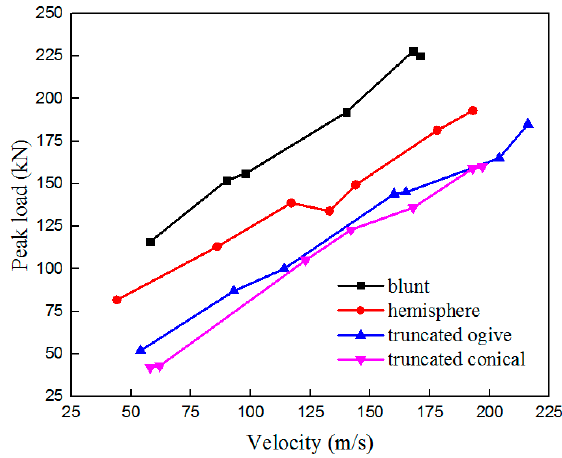
Figure 19. Peak load of various nose-shape projectiles vs. impact velocity.